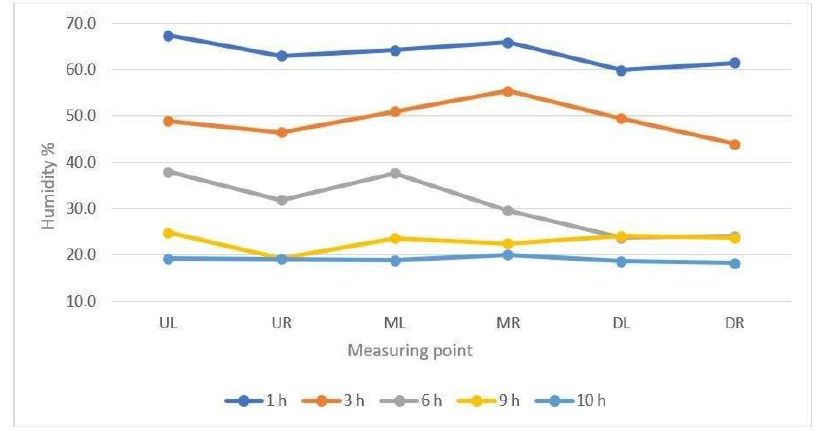
Figure 12. Changes in moisture content of beef samples taken from different zones of the drying chamber, chamber 5.